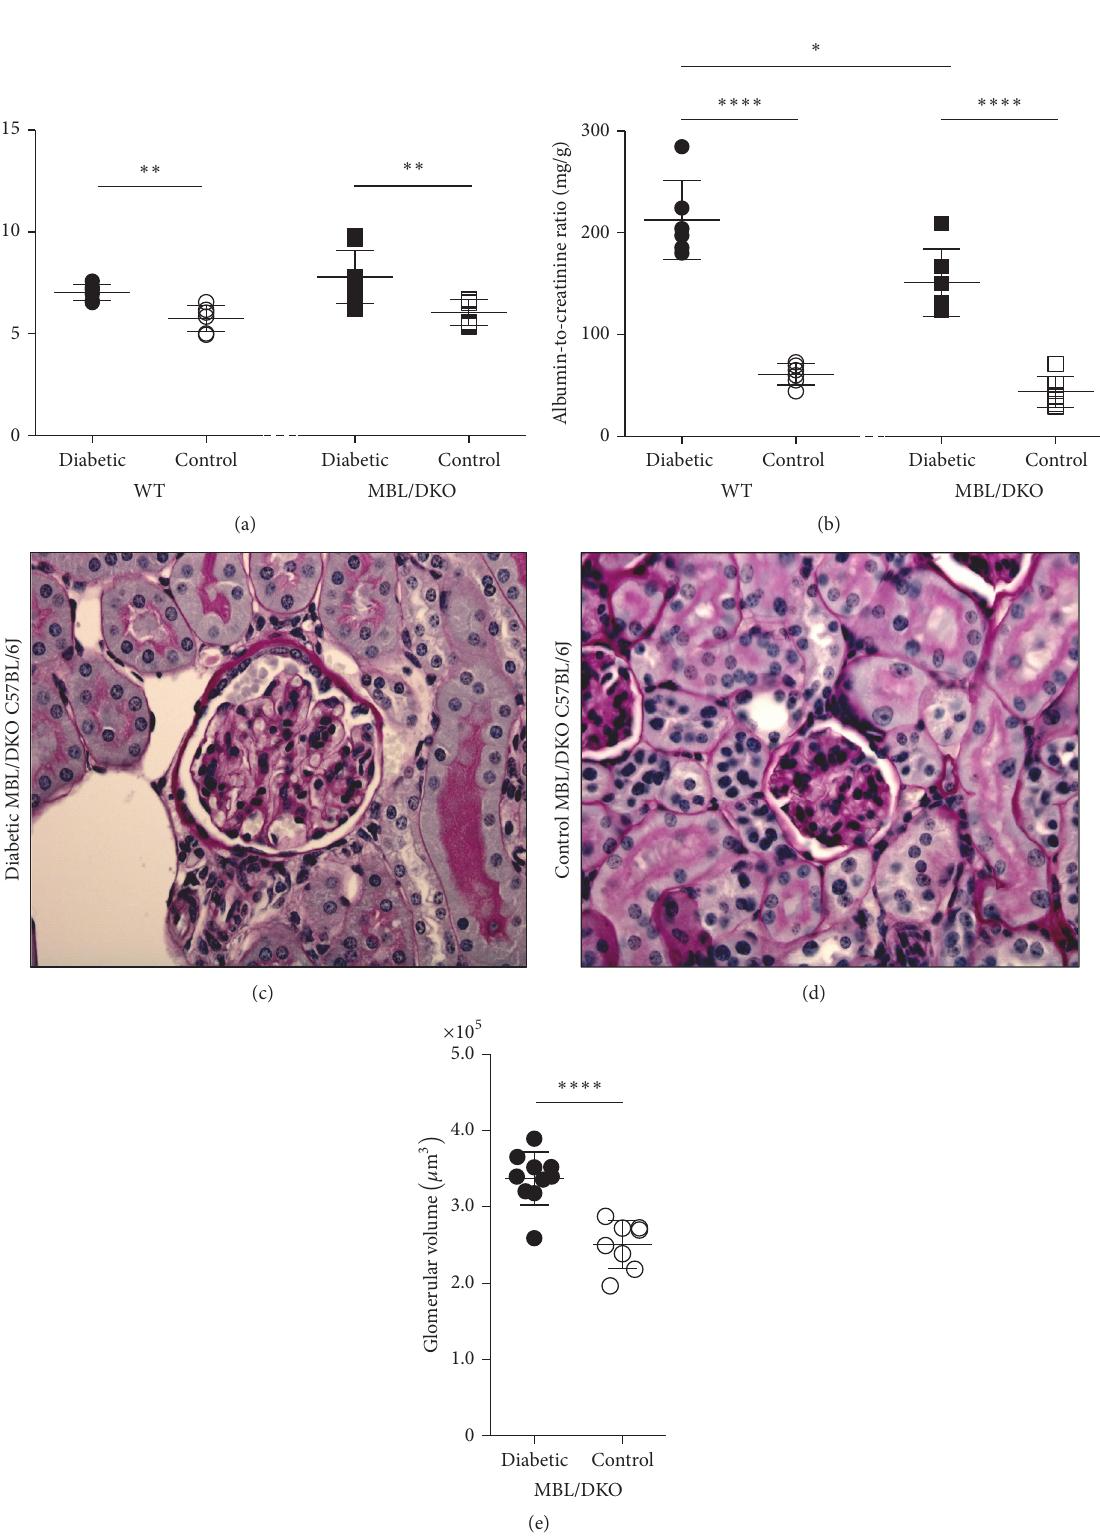
Figure 3: Kidney-to-body weight ratio, albumin-to-creatinine ratio, and kidney glomerulus estimation. (a) Kidney-to-body weight ratio of diabetic C57BL/6J WT mice ( 𝑛 = 6 ), nondiabetic control C57BL/6J WT mice ( 𝑛 = 6 ), diabetic C57BL/6J MBL/DKO mice ( 𝑛 = 6 ), and nondiabetic control C57BL/6J mice MBL/DKO ( 𝑛 = 6 ). (b) Albumin-to-creatinine ratio (AcR) measurements at study end for WT and MBL/DKO mice. (c and d) Light microscope representation of glomerulus from diabetic C57BL/6J MBL/DKO mice (c) and nondiabetic C57BL/6J MBL/DKO control mice (d). (e) Estimation of glomerulus volume in diabetic C57BL/6J MBL/DKO mice ( 𝑛 = 13 ) and nondiabetic control C57BL/6J MBL/DKO mice ( 𝑛 = 8 ). Statistical tests are indicated in figure when significant ( ∗ 𝑝 < 0.05 , ∗∗ 𝑝 < 0.001 , and ∗∗∗∗ 𝑝 < 0.0001 ). Data is presented as mean (solid line) with SDs